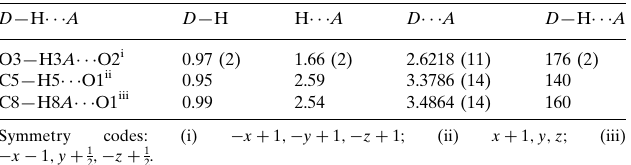
Hydrogen-bond geometry (A˚ , (cid:1)